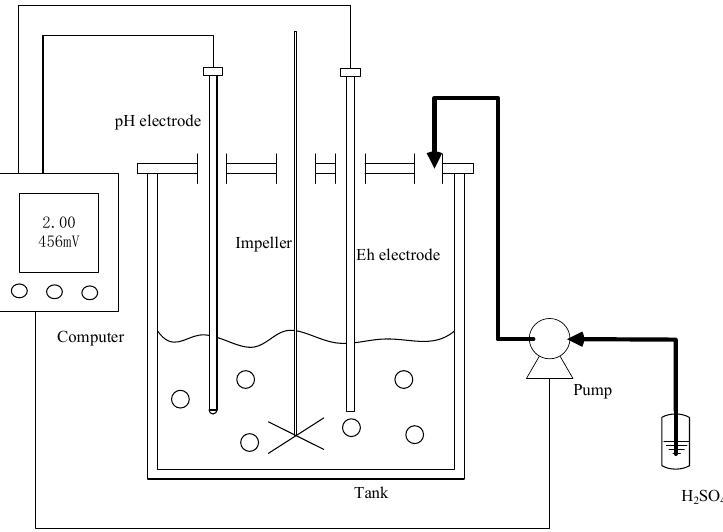
Figure 1. pH-stat batch stirred tank reacting system.